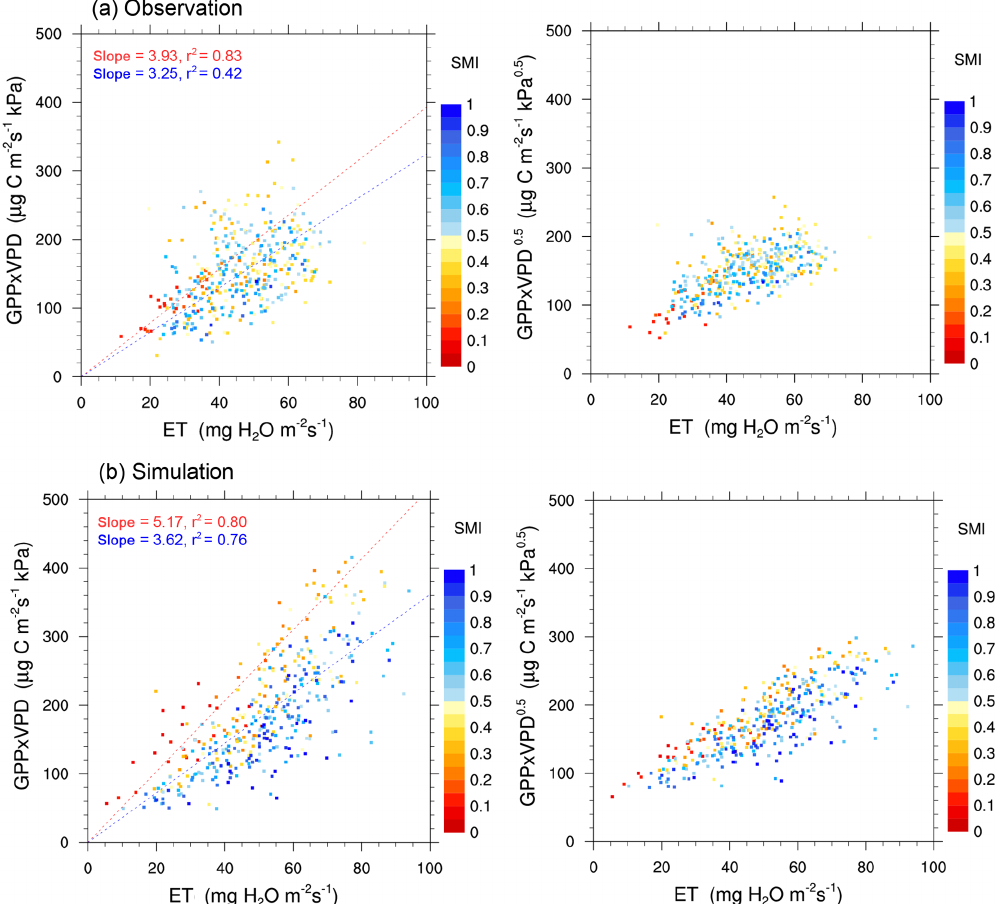
Figure 4. The dependence of the product of daytime mean gross primary production (GPP in µgCm − 2 s − 1 ) and daytime mean vapour pressure deficit (VPD) on evapotranspiration (ET in mg H 2 O m − 2 s − 1 ) (i.e. GPP × VPD / ET, which represents the inherent water use efficiency, IWUE), and the dependence of the production of GPP and the square root of VPD on ET (i.e. GPP × VPD 0 . 5 / ET, which represents the underlying water use efficiency, uWUE) in the summer months (June, July, August) of the 11-year study period (from 1999 to 2009) from (a) observation and (b) the JSBACH simulation. Data are categorized according to daily mean soil moisture index (SMI). The fitted lines for the dependence of the product of GPP and VPD on ET are for the data under SMI < 0 . 2 (red line) and the data under 0 . 2 ≤ SMI < 1 (blue line); both fittings are statistically significant ( p value < 0 . 05). No lines were fitted for the dependence of the production of GPP and the square root of VPD on ET, as the data under SMI < 0 . 2 and data under 0 . 2 ≤ SMI < 1 are more converged in a line in comparison to the dependence of the product of GPP and VPD on